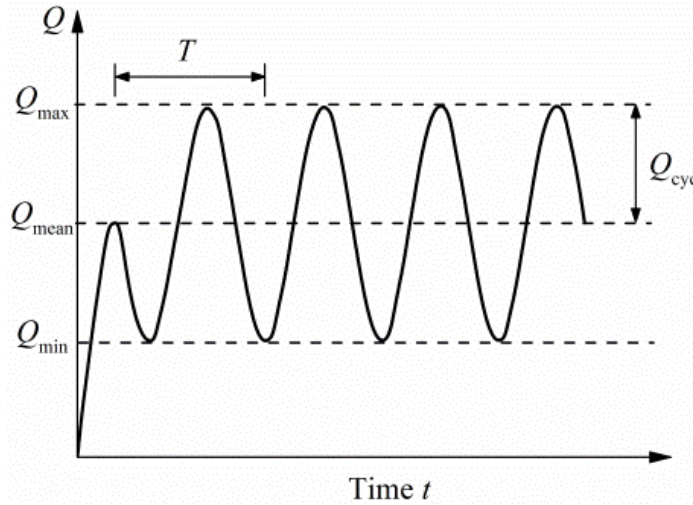
Figure 3. Patten of cyclic loading.